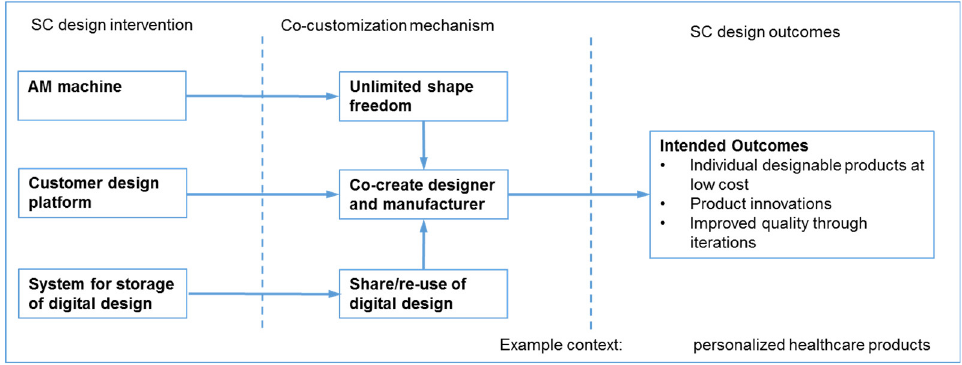
Figure 2. Co-customization mechanism.